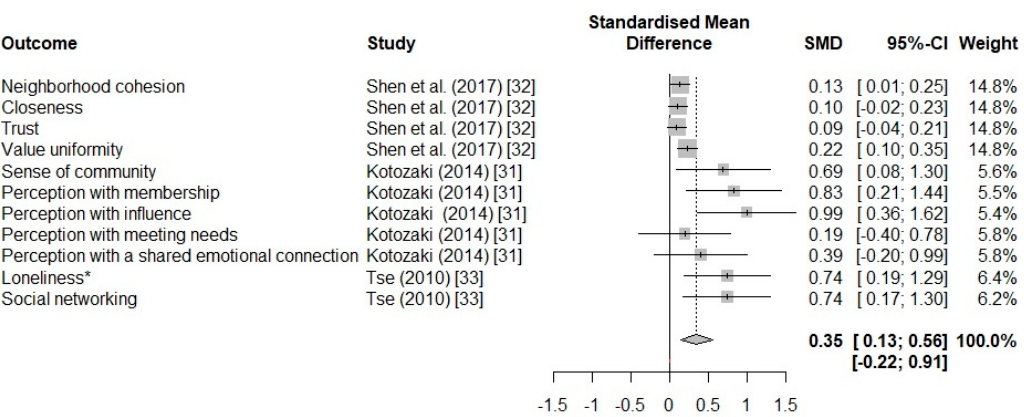
Figure 2. Forest plot showing the results of the meta-analysis on the effect sizes, including the 95% confidence interval effect size, of gardening and horticulture on social health outcomes for 11 comparisons. (* The scores of the “Revised University of California, Los Angeles (UCLA) Loneliness Scale” [42] were reversed, since a higher score indicated greater perceived loneliness, thus lower psychosocial well-being). SMD = Standardized Mean Difference; CI = Confidence Interval.